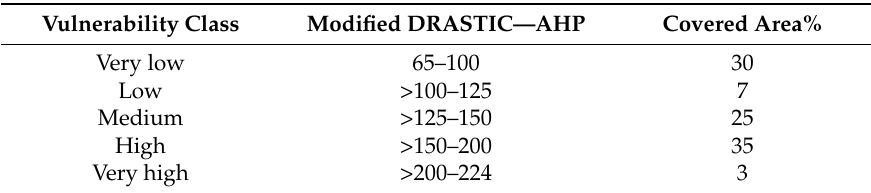
Table 6. Result of Modified DRASTIC index ratio based on the AHP